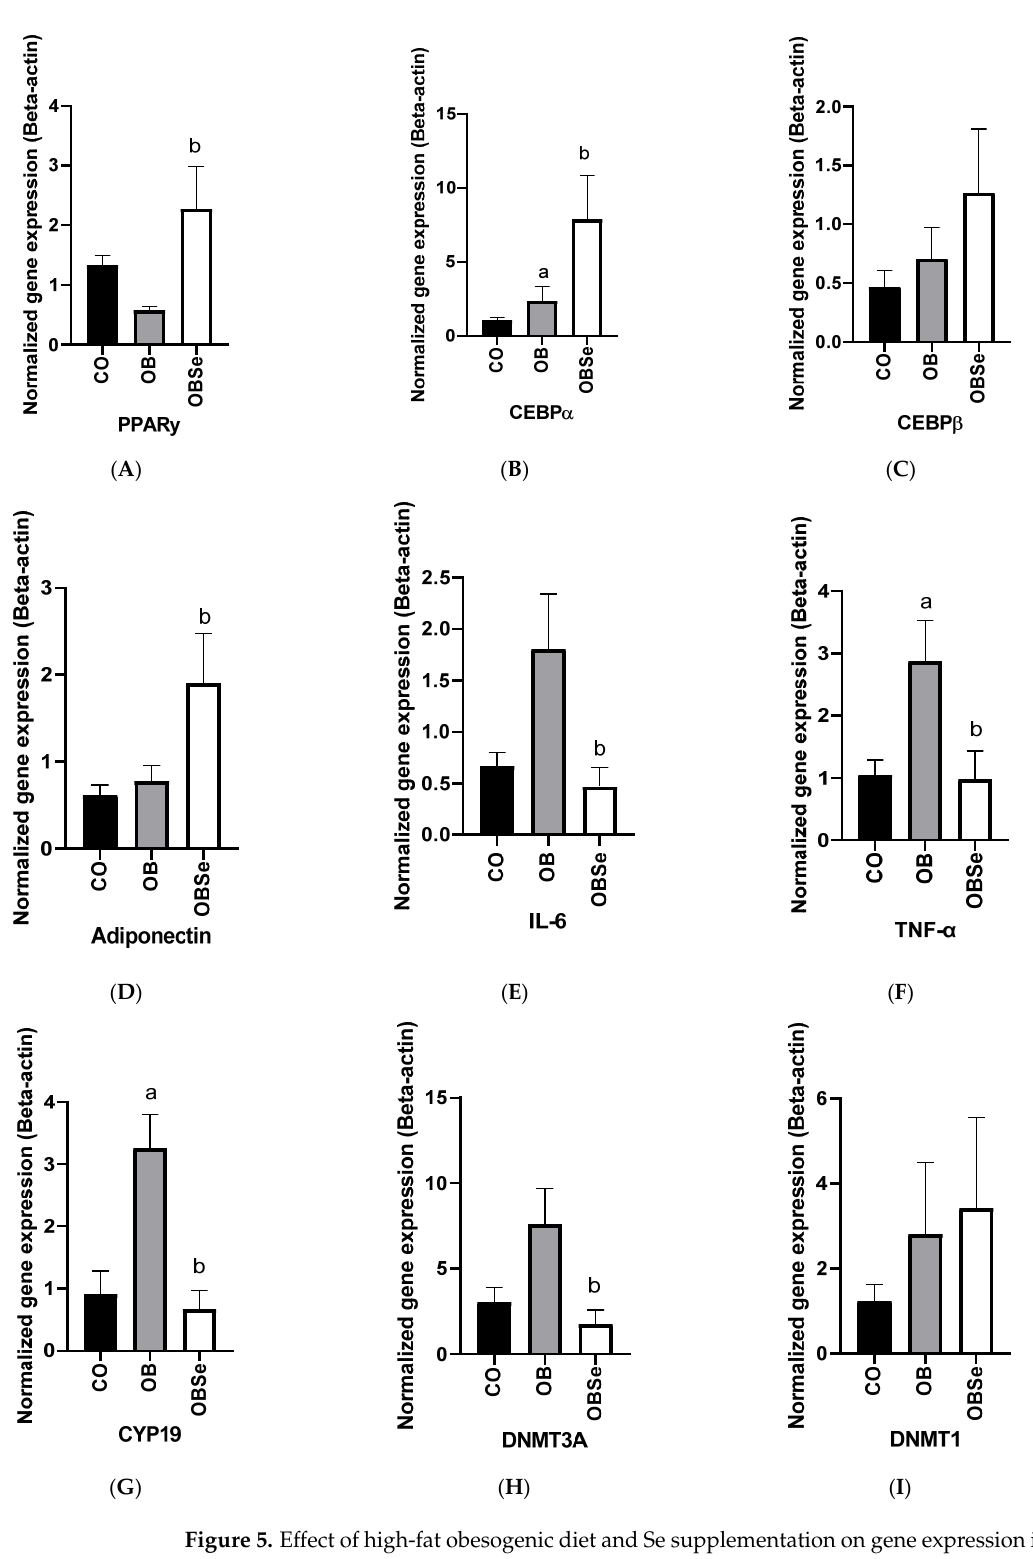
( C ) Figure 6. Effect of high-fat obesogenic diet and Se supplementation on sperm miRNA levels: ( A ) miR-15b; ( B ) miR-200c; ( C ) miR-497. Data represent the mean ± SEM ( n = 7/group). Statistically